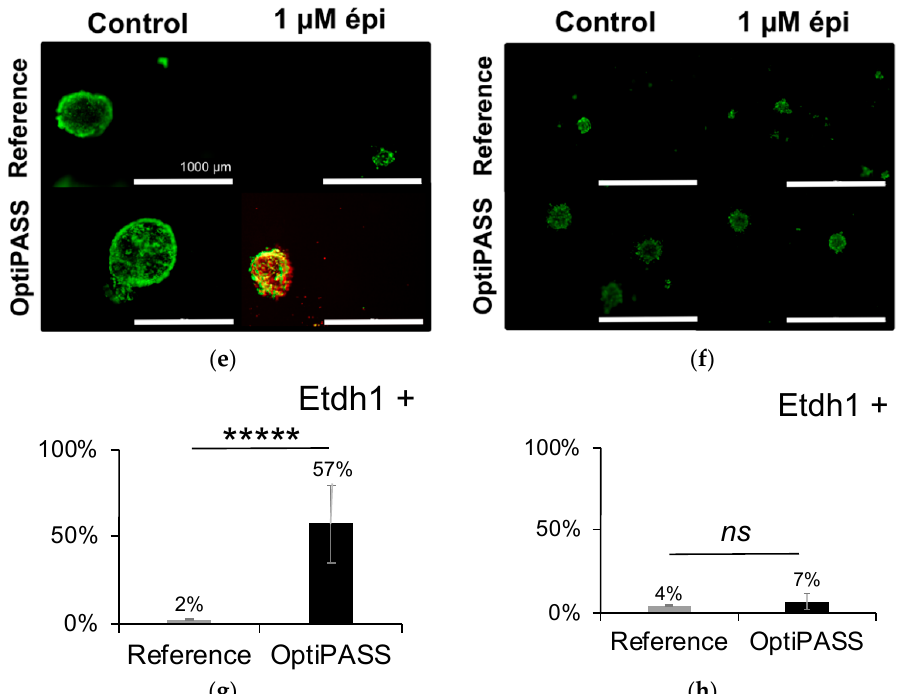
Figure 4. MDA-MB-231 ( a , c , e , g ) and SUM1315 ( b , d , f , h ) spheroids sensitivity to epirubicin in OptiPASS medium. Spheroids formed with reference or OptiPASS medium were treated with 1 μ M of epirubicin for five days. ( a , b ) Spheroid size monitoring after epirubicin treatment: the mean size of control and treated spheroids was measured for the five days of treatment with Cytation3MV (BIOTEK), n = 6, bars = s.d. ( c , d ) Spheroid viability after epirubicin treatment: the percentage of treated spheroids viability was determined by the ratio of metabolic activity of treated spheroids on untreated spheroids at day five. Then, the viability was normalized on the percentage of treated spheroid size (on control spheroid size) calculated at day five from each cell culture medium, n = 6, bars = s.e.m. ( e , f ) Spheroid viability/mortality profile after epirubicin treatment: after five days of treatment, control and treated spheroids were incubated with Calcein-AM and ethidium-homodimer-1 (Etdh1+) (Live/dead kit). green = viable cells, red = dead cells. Observations were made with Cytation3MV with focal height fixed to the center of each spheroid. Scale bar = 1000 μ m. ( g , h ) mean percentage of Etdh1+ staining in treated spheroids compared to control spheroids (error bars = s.d.). ns = non-significantly different, *** = p < 0.001, *****= p < 0.00001, two-sided Student’s t-test comparison.